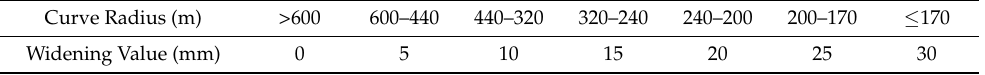
Figure 5. Schematic of gage widening calculations utilized in Japan. Table 5. Gage widening values used in Japanese railways (mm).